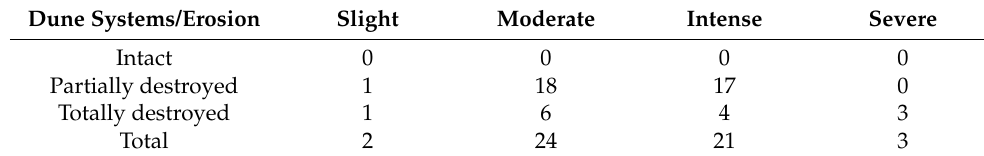
Table 4. Summary of the classification of coastal erosion processes according to their intensity. Dune